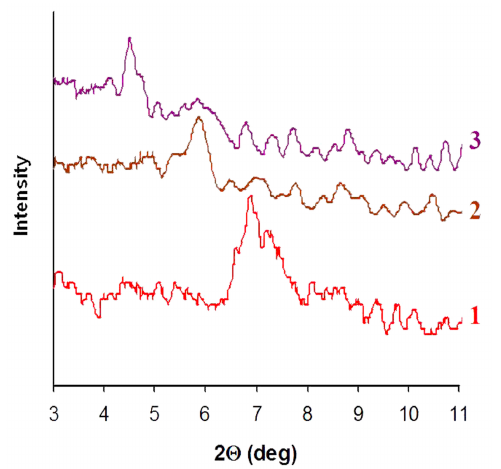
Figure 7. X-ray diffraction patterns of (1) initial Mt and bicomponent systems in ratio 90:10; (2) P Ct -Mt; (3) P Rh -Mt.